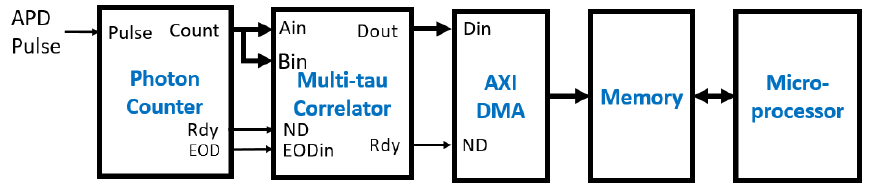
Figure 18. FPGA multi-tau correlator in an embedded diffuse correlation spectroscopy device using a microprocessor.